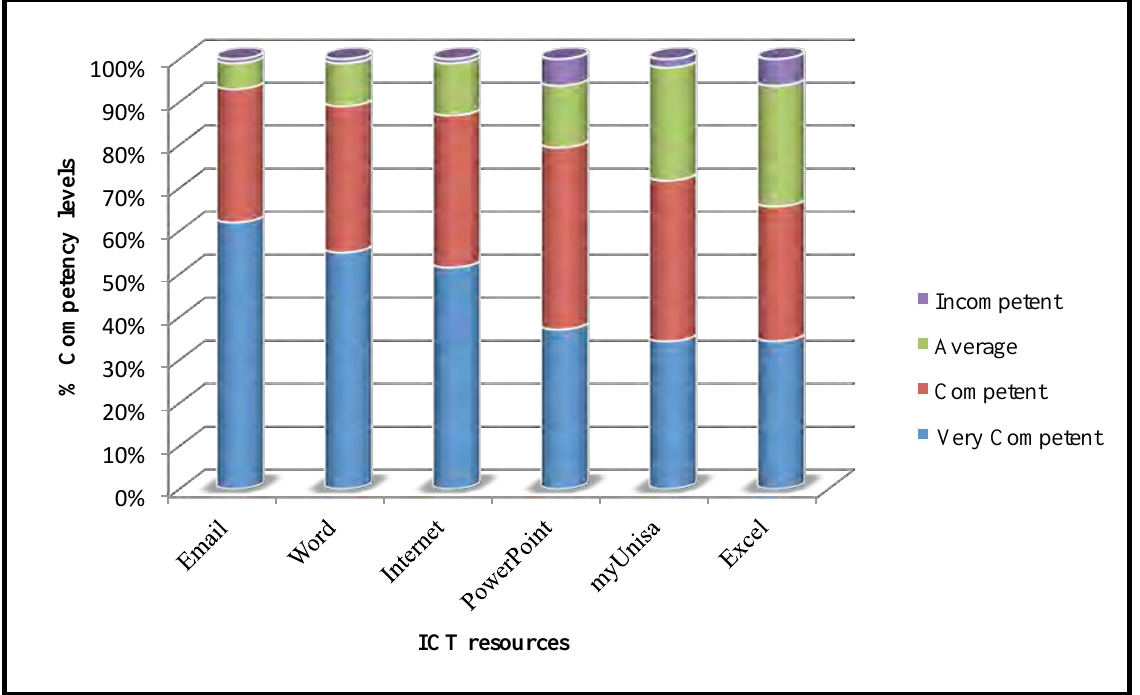
Figure 3: Competence of respondents in ICT